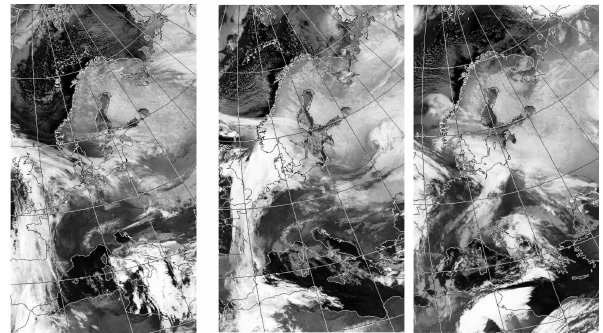
Figure 4. AVHRR images taken by the polar orbiting NOAA-17 satellite in the thermal infrared (10.3–11.3µm) channel 4, from left to right, at 01:35UTC 20 February 2007, 01:24UTC 21 Febru- ary 2007 and 01:14UTC 22 February 2007 (from http://www.sat.